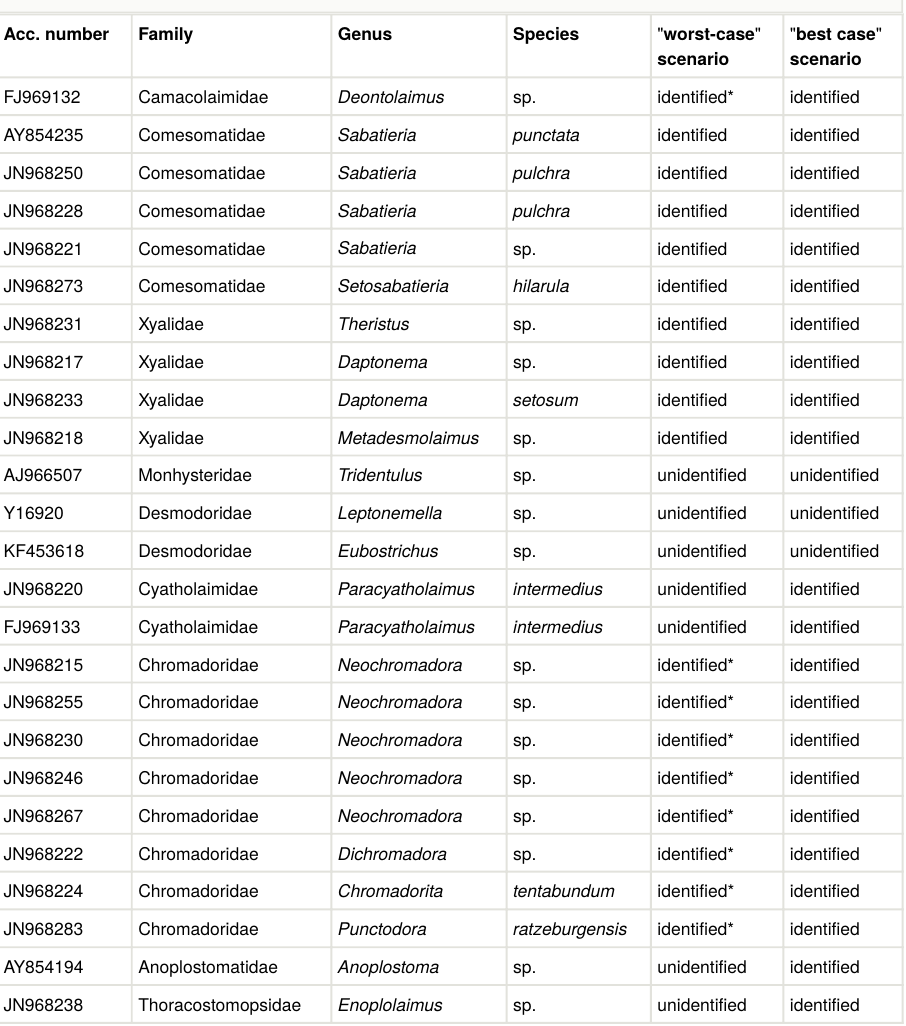
the families Camacolaimidae (bootstrap support of 52%) and Chromadoridae (bootstrap